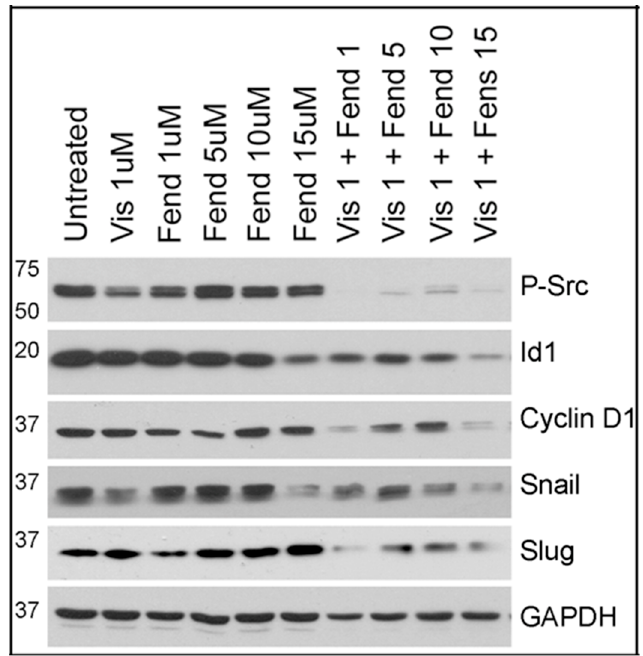
Figure 7. Panc1 cells treated with visudyne and varying concentrations of fendiline show additive effect on inhibition of oncogenic signaling: Samples from Panc1 cells treated with indicated concentrations of fendiline or visudyne alone or in combination were analyzed using phospho-Src, Id1, Cyclin D1, Snail or Slug antibodies by western blotting. Results show that combinatorial treatment reduces the levels of all these proteins even at the lowest concentration of fendiline. GAPDH antibody was used to reprobe the blot for protein normalization.